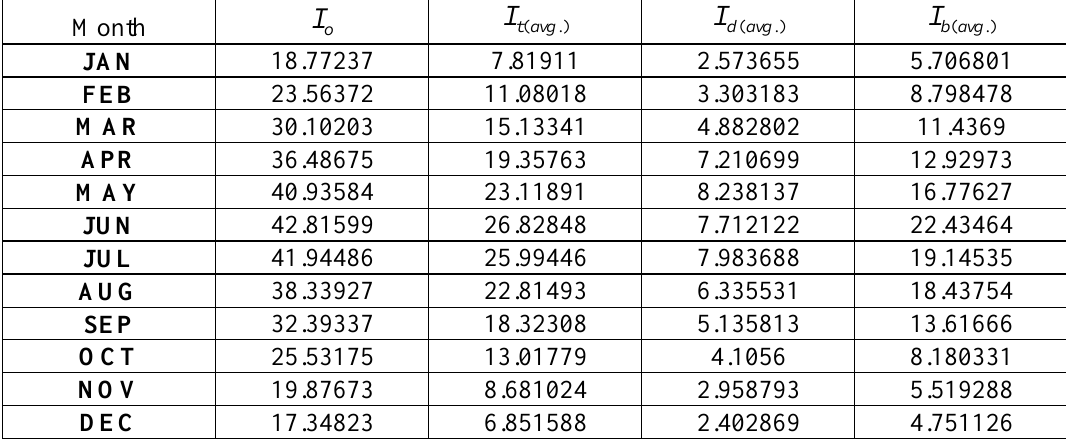
Table1: Extraterrestrial solar radiation and a metrological measured data (average monthly mean global, diffuse and direct solar